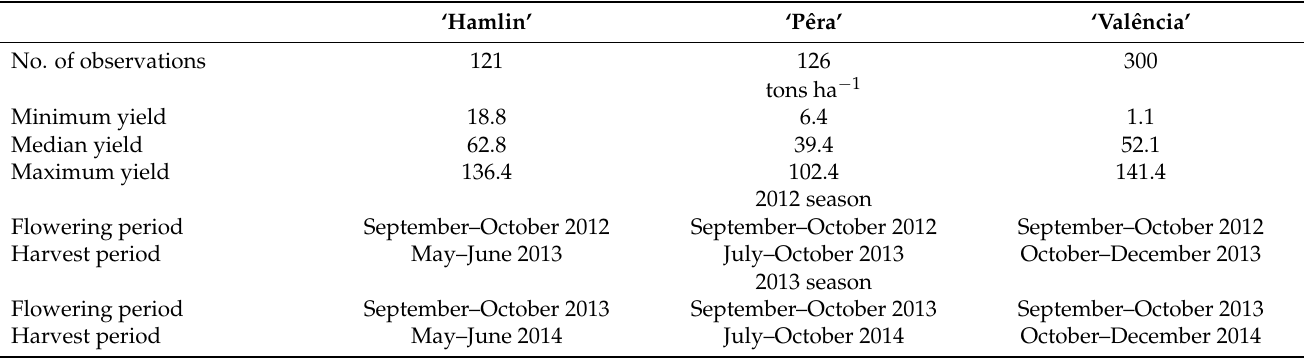
Table 1. Number of observations, yield ranges, and flowering and harvesting periods for